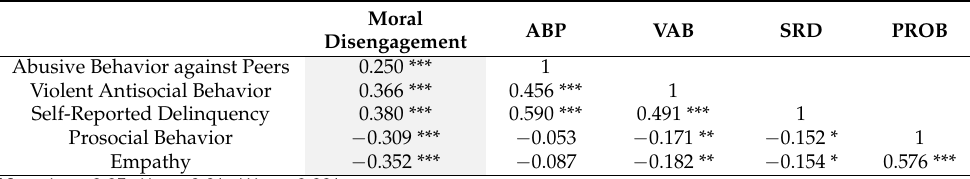
Table 7. Spearman correlations between MD (summation of the 10 items) and related constructs. Moral ABP VAB SRD PROB Disengagement 0.250 ***